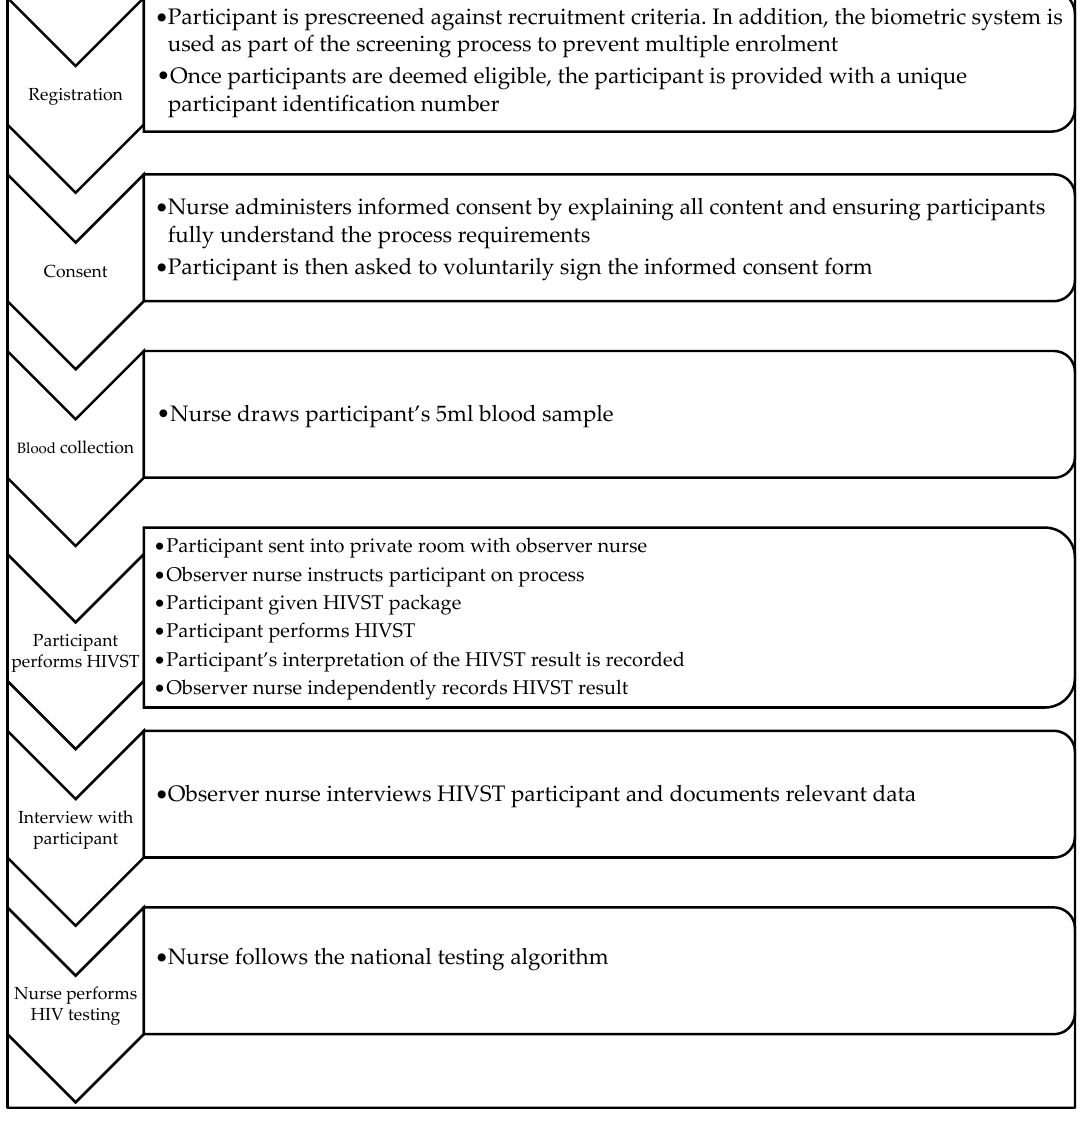
Figure 2. Evaluation study process.